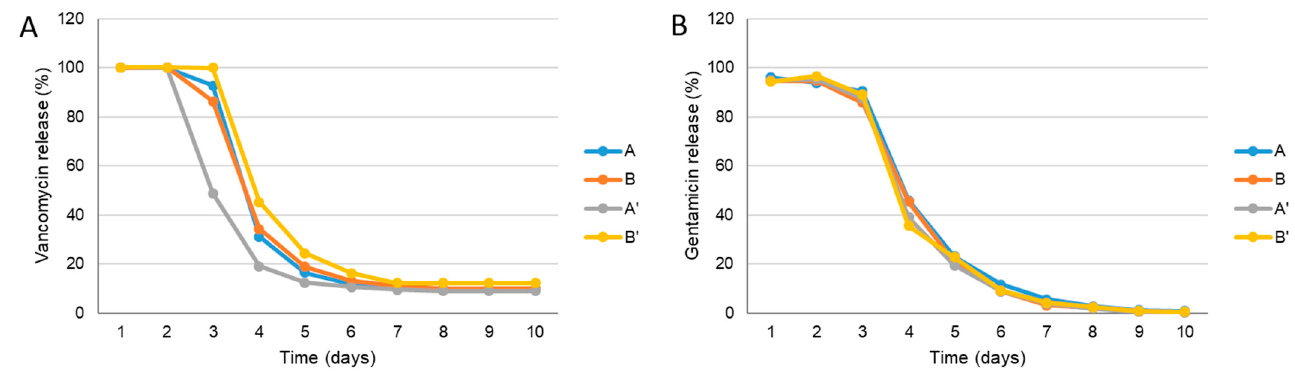
Figure 5. Vancomycin ( A ) and gentamicin ( B ) concentrations present in the solution released from Coll/nanoHA samples with and without sterilization, at different time points until 10 days.